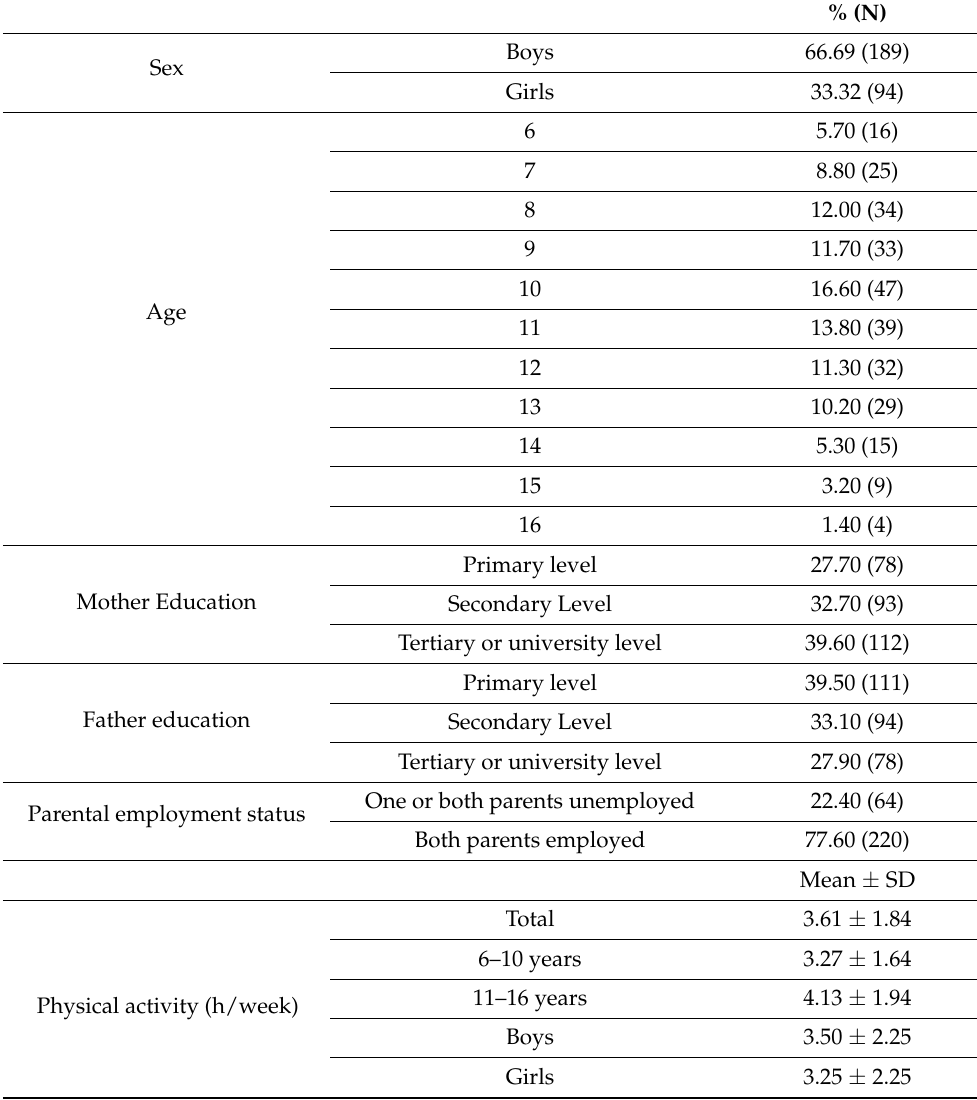
Table A1. Characteristics of survey